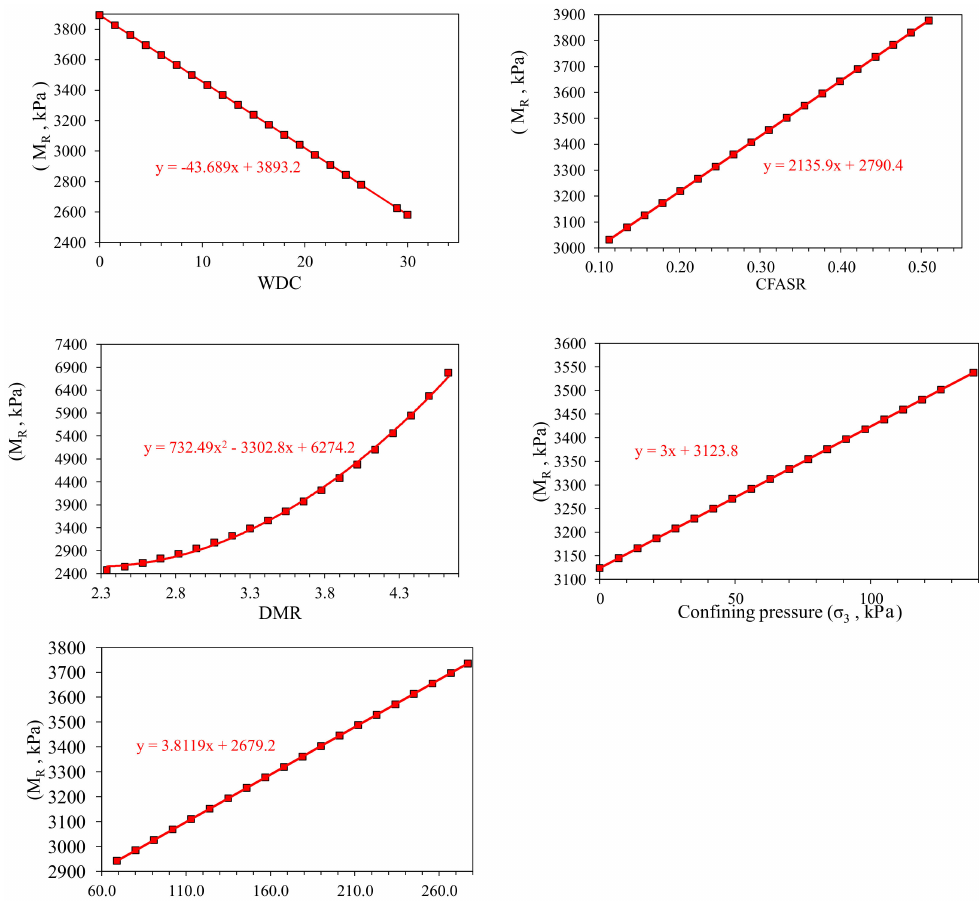
Figure 7. Parametric study of the GEP model.